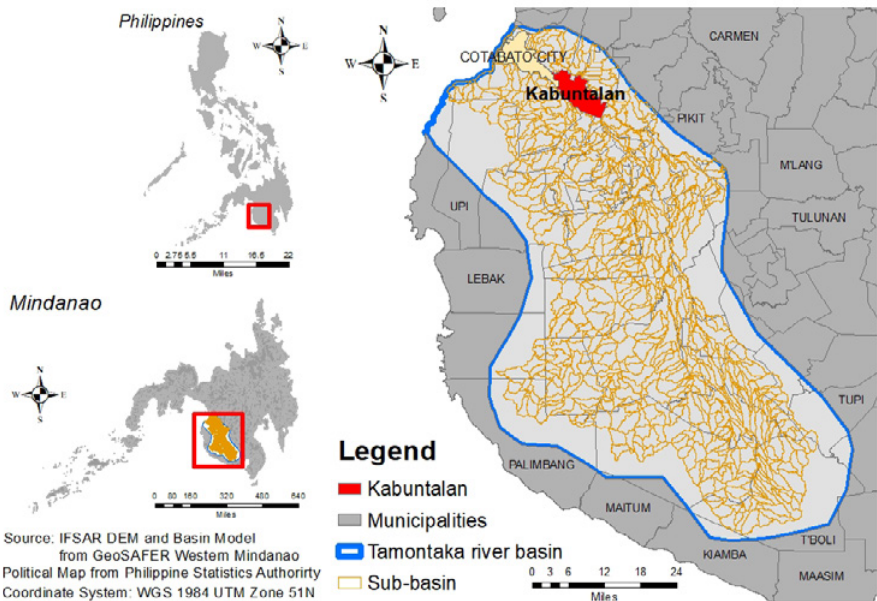
Fig. 1: Location Map of the study area